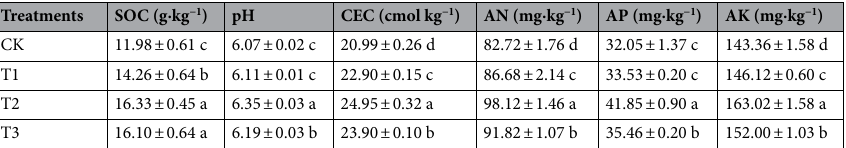
Table 1. Effects of different treatments on soil physicochemical properties. Different letters indicate significant differences at p < 0.05 (according to Duncan’s multiple range test). SOC soil organic carbon, CEC cation exchange capacity, AN available nitrogen, AP available phosphorus, AK available potassium.